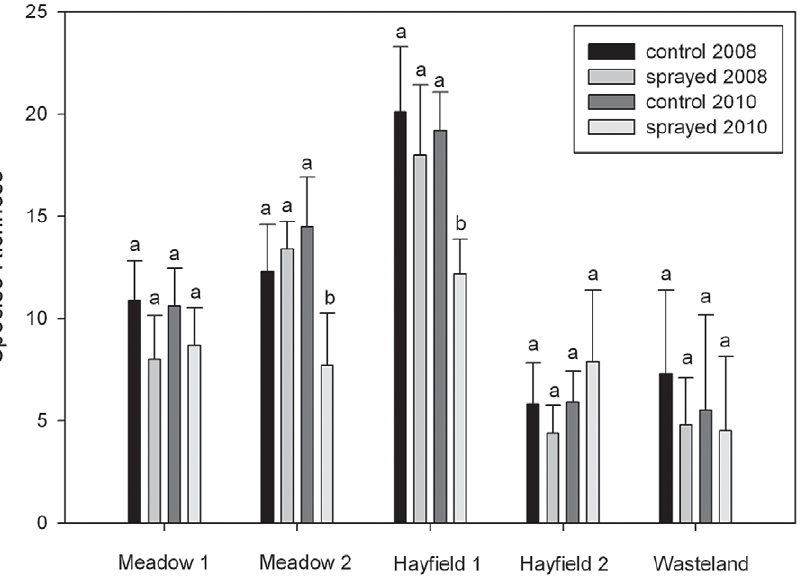
Figure 1. Species richness in subplots before the study (2008) and at the end of the experiment (2010). Error bars indicate SD and letters indicate differences within plot locations according to Fisher’s LSD test ( a ,